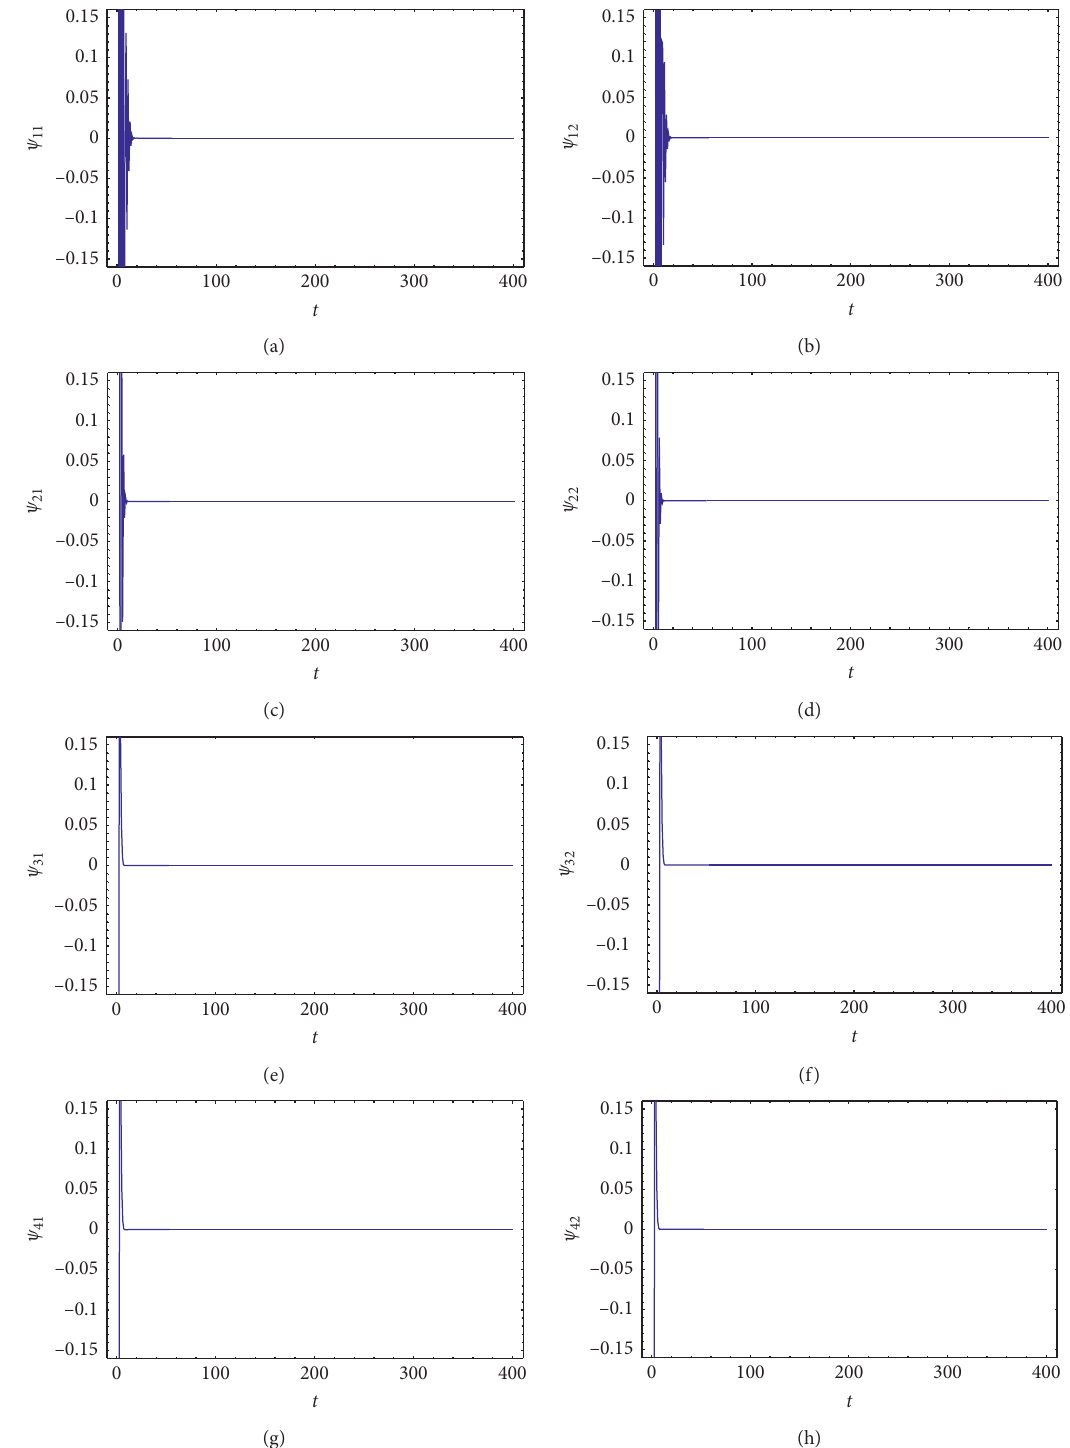
Figure 4: The controller’s time evolution. (a) ( Ψ , t ) layout. (g) ( Ψ (f) ( Ψ 32